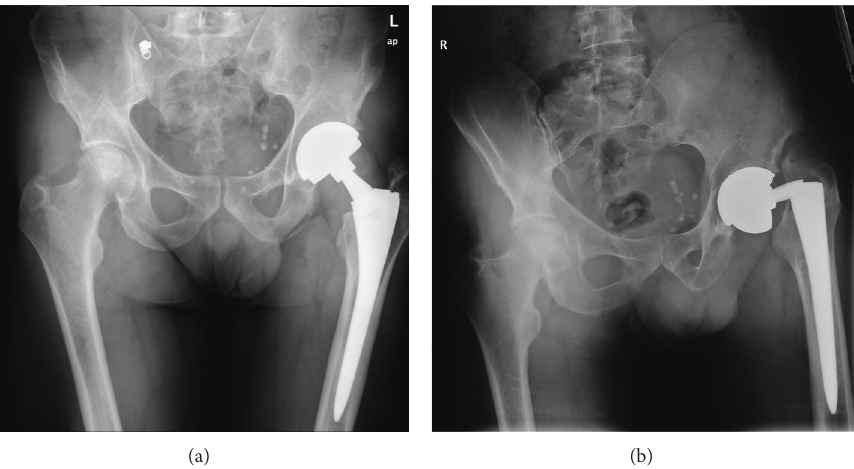
Figure 1: (a) Plains radiographs of the pelvis showing a Profemur Modular stem and Conserve Cup (Wright Medical Technology, Inc., 5677 Airline Road, Arlington, TN 38002) with a long modular titanium neck with 8 degrees of varus, metal on metal bearing surface, and a 50 mm